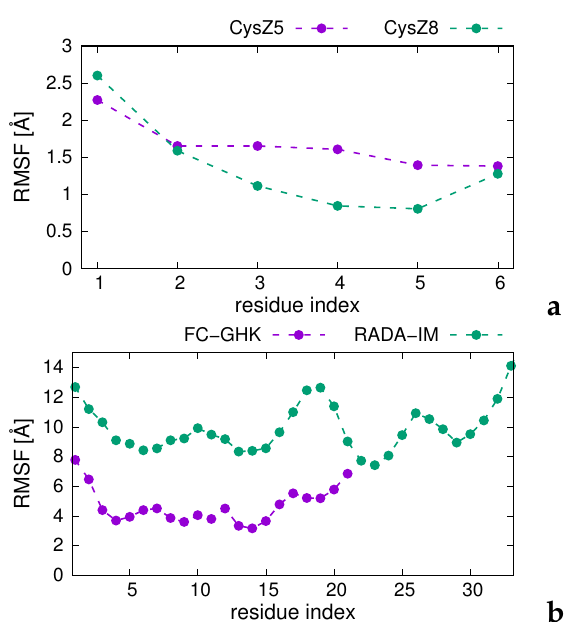
Figure 8. C α -atom root mean square fluctuations (RMSF) for CysZ5, CysZ8, FC-GHK and RADA-IM plotted in residue index. The graphs for CysZ5 and CysZ8 are shown in panel ( a ), while those for FC-GHK and RADA-IM are shown in panel ( b ). The RMSFs were calculated as the standard deviations of the positions of the C α atoms over all five models obtained in MREMD simulations of eight-chain systems and subsequent cluster analysis at T = 298 K and all chains from those of the mean chain structure The graphs were drawn with gnuplot